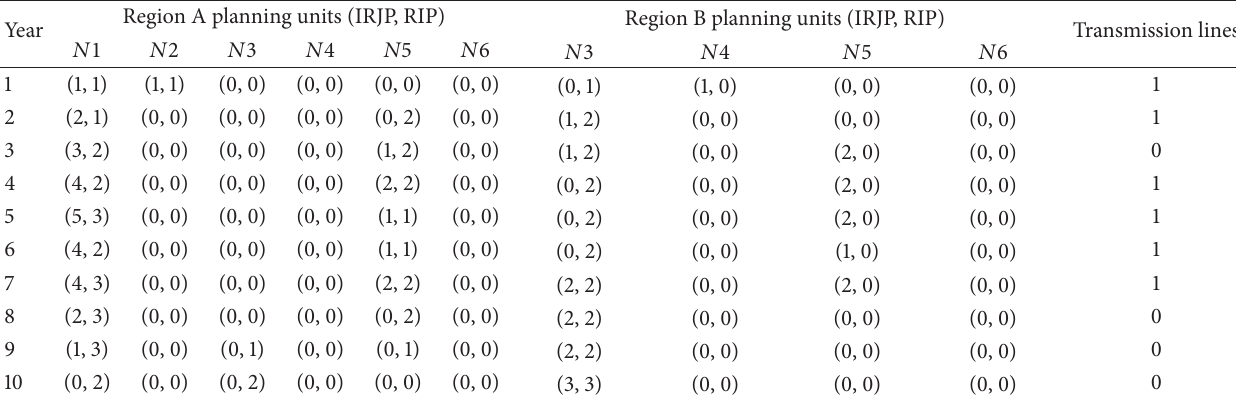
Table 8: The investment optimization results in IRJP mode and RIP mode.